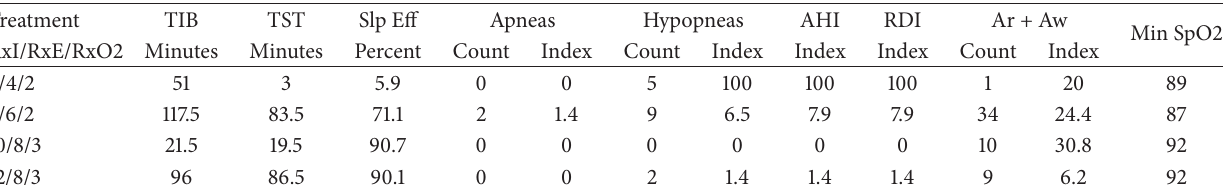
Table 6: Treatment parameters and results/with dual mask.